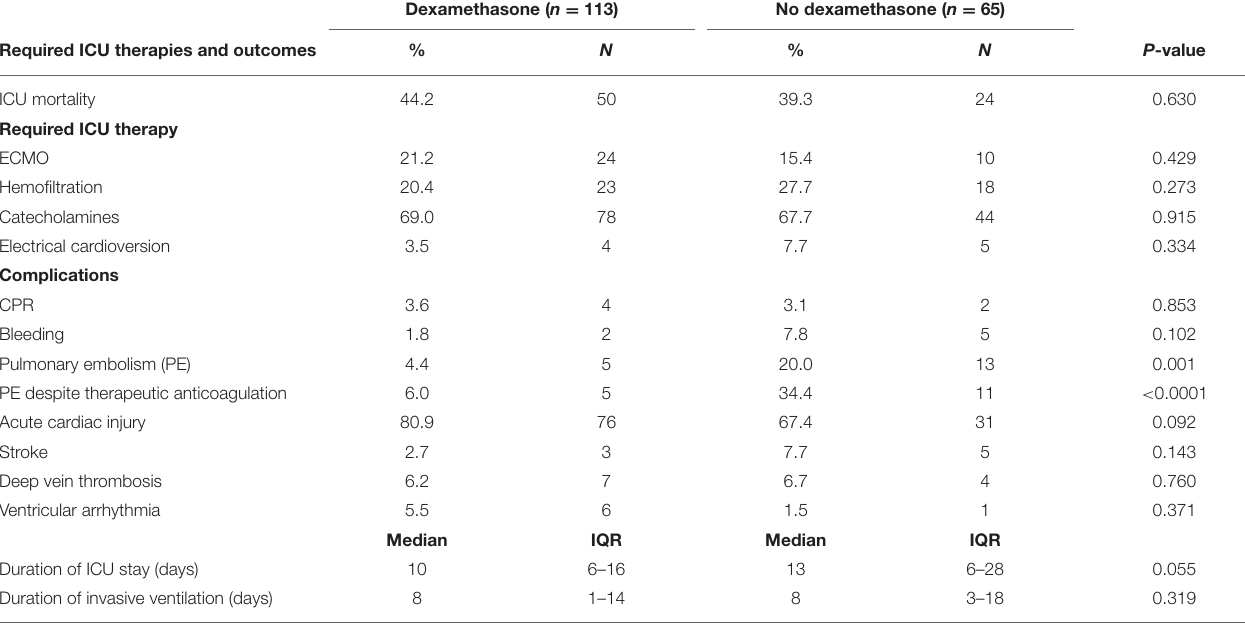
TABLE 4 | Required ICU therapies and outcomes in patients treated with dexamethasone vs. controls. Dexamethasone ( n =